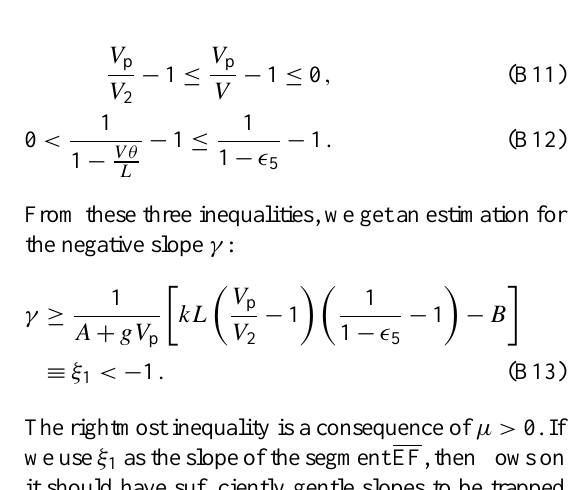
Fig. B1. A trapping region in the log θ -log V plane. Dotted line rep- resents nullcline I, dashed curve represents nullcline II, black dot is the equilibrium point X 0 , thick solid line represents a hexagon H=ABCDEF that bounds the trapping region R, thin solid lines represent the asymptotes for nullcline II, and arrows represent the